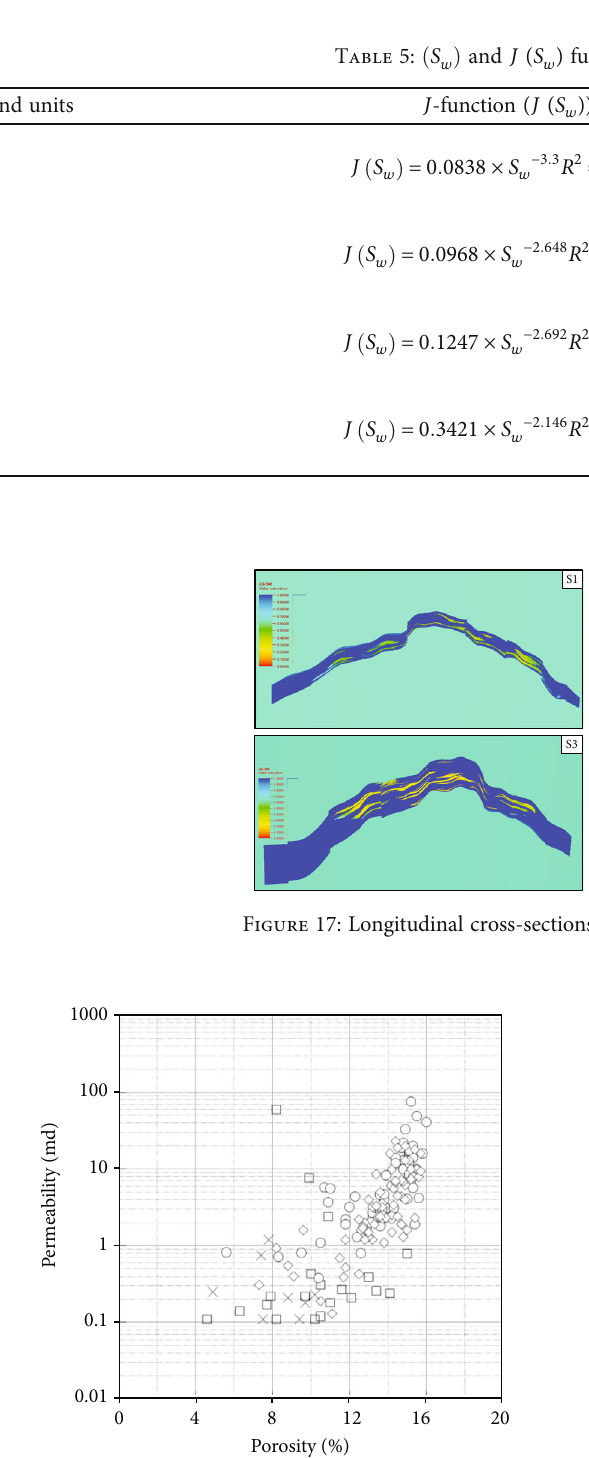
Figure 18: Intersection diagram of porosity and